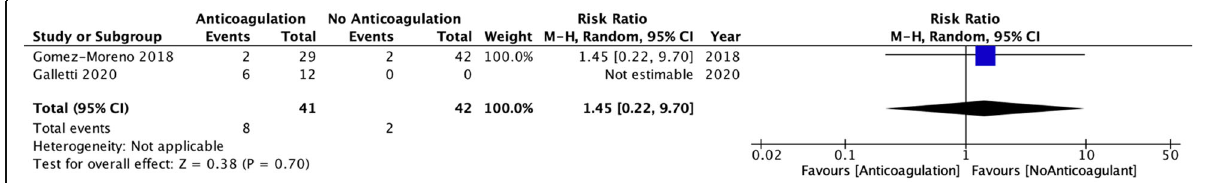
Fig. 3 Forest plot comparing pausing of anticoagulation therapy peri-operatively with controls of no anticoagulation. Mean relative risk and pooled relative risk is represented by the blue squares and black diamond